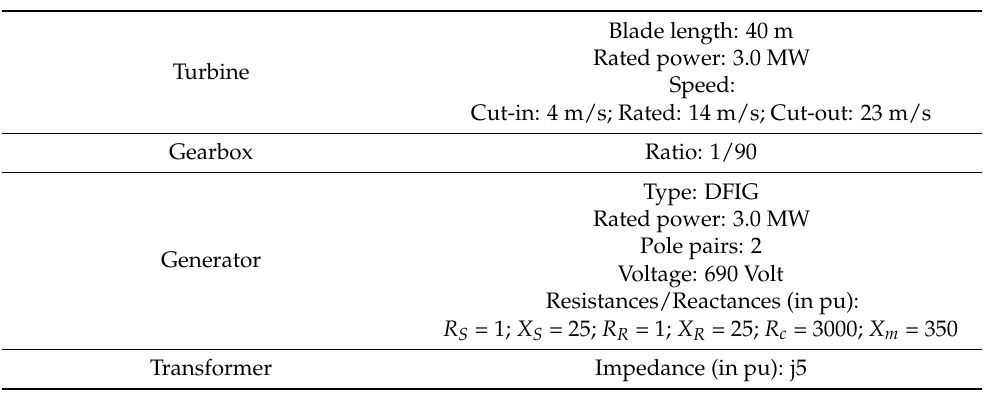
Table 5. WTG unit